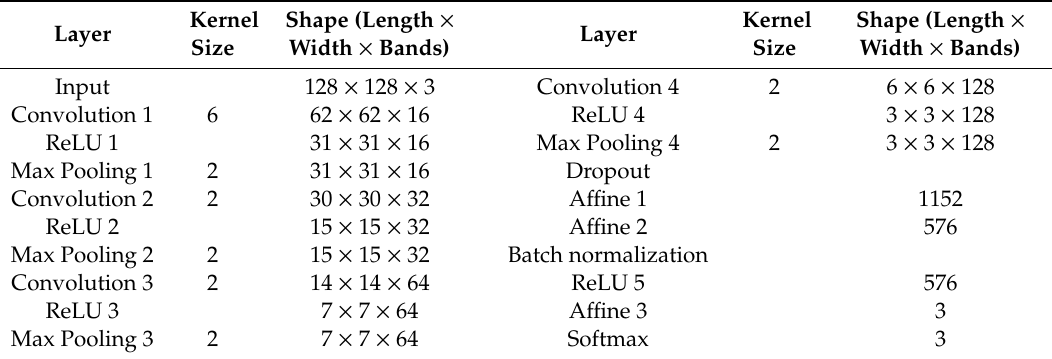
Figure 7. Convolutional neural network (CNN) architecture adopted in this study. Table 5. Kernel and shape size adopted in the CNN model.